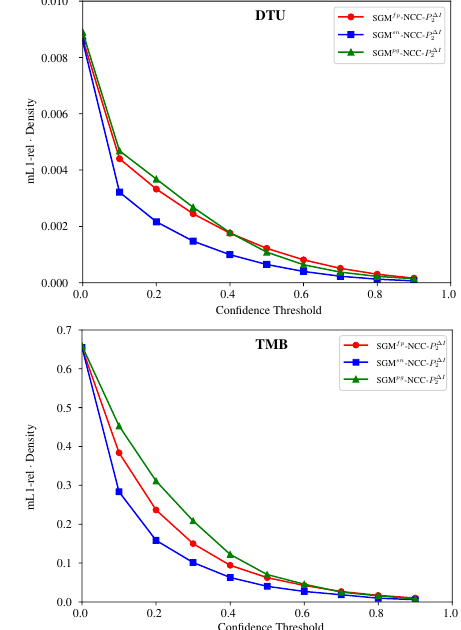
(b) ROC curves plotting normalized mean L1-rel over the confidence threshold which is used to mask the depth map. The top graph depicts the results achieved by three SGM x configurations on the DTU dataset. The bottom graph shows the results achieved on the TMB dataset. Figure 3. Quantitative evaluation of twelve different SGM x